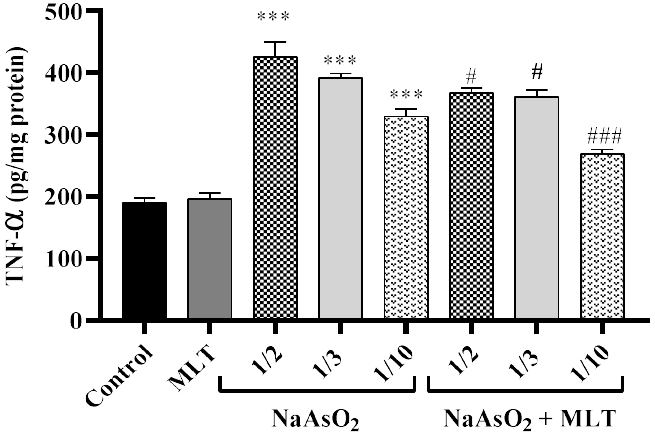
Figure 1. Assessment of pro-inflammatory TNF-α. Abbreviations: TNF-α: tumor necrosis factor- alpha; MLT; melatonin, NaAsO 2 ; sodium arsenite; Results are expressed as mean ± SEM for five animals in each group (n = 5). *** p < 0.0001 (Vs. control or melatonin) ### p < 0.0001; # p < 0.05 (Vs. ½ LD50 NaAsO 2 ).